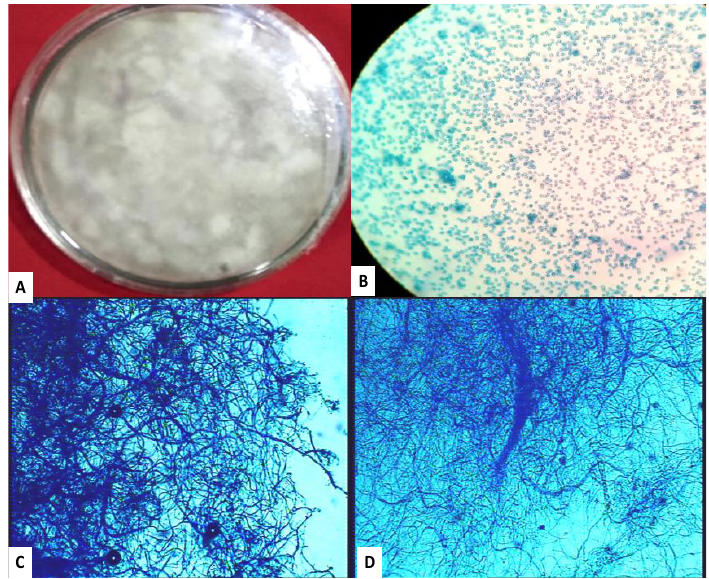
Figure 2. Light microscopic images of ( A ). P. lilacinus fungus culture on PDA media; ( B ). Conidia of fungus; ( C , D ). Mycelium of fungus.